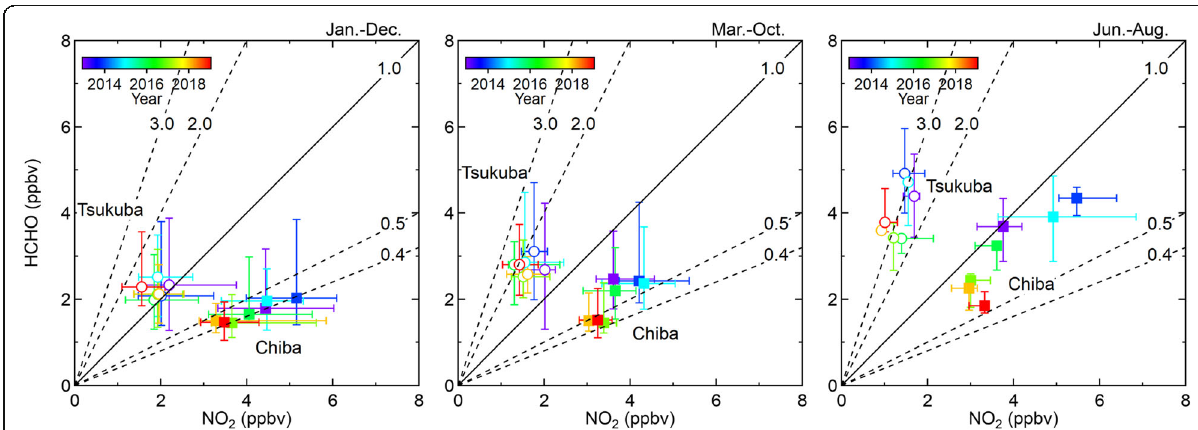
Fig. 7 HCHO-NO 2 correlations for Chiba (squares) and Tsukuba (circles). Each data point represents the median value of monthly means using data collected over (left) 12, (middle) 8 (March to October), and (right) 3 months (June to August). Error bars represent 67% ranges. Different years are shown in different colors. The solid and dashed lines represent constant HCHO/NO 2 concentration ratios at values given on the respective